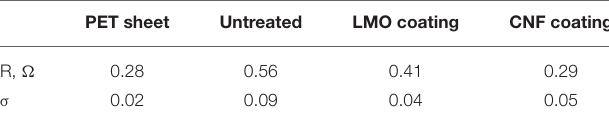
TABLE 2 | Resistance of 4.0 × 0.5 mm 2 printed lines. PET sheet Untreated LMO